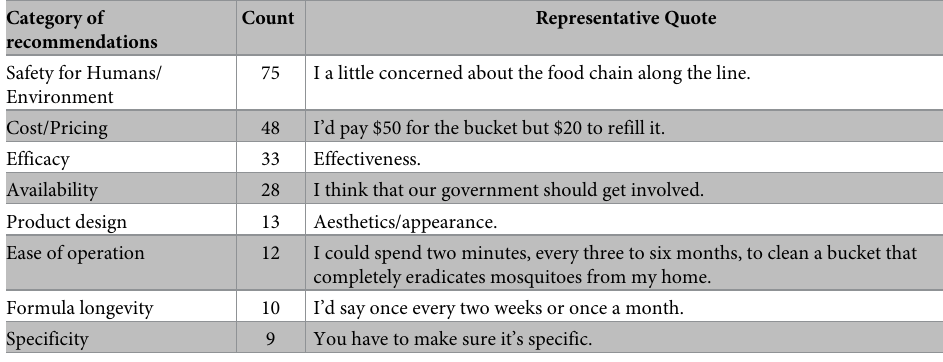
Table 4. Categories of recommendations offered by attendees of the community engagement